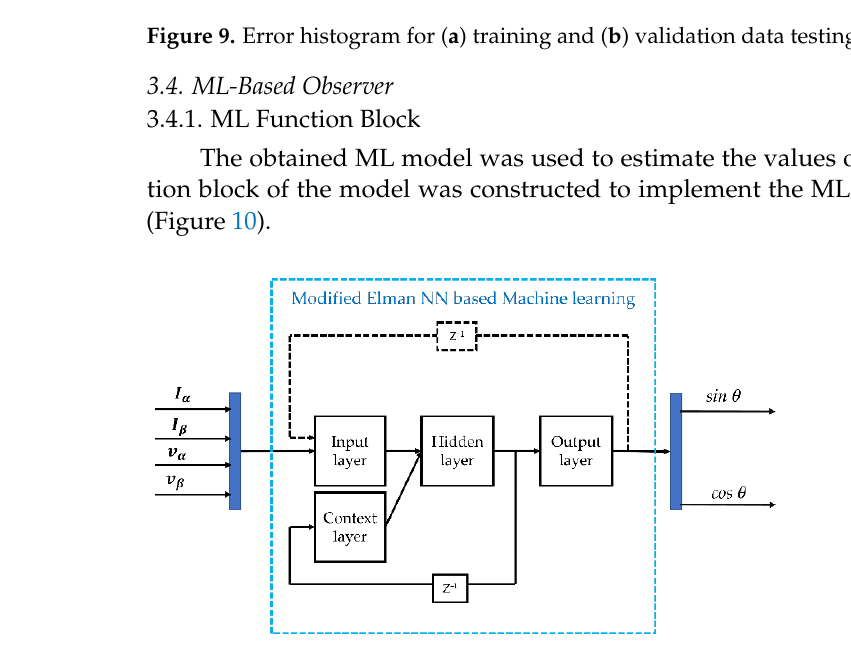
Figure 10. Function block architecture of the ML model.